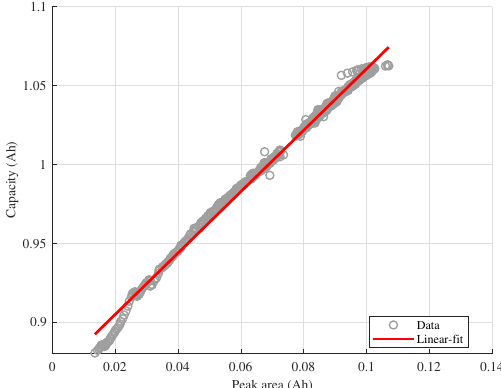
Figure 4. Example of linear (solid line) model fitting for battery #18 first life data (markers).